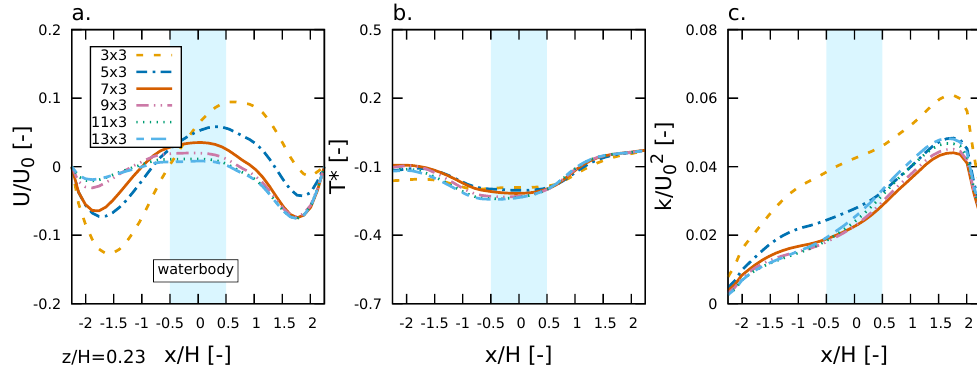
Figure 3. Normalised profiles along a horizontal sampling line in the middle of the open square ( y / H = 0) and at pedestrian level ( z / H = 0.23): ( a ) streamwise velocity ( U / U 0 ); ( b ) temperature ( T ∗ ); ( c ) turbulent kinetic energy ( k / U 02